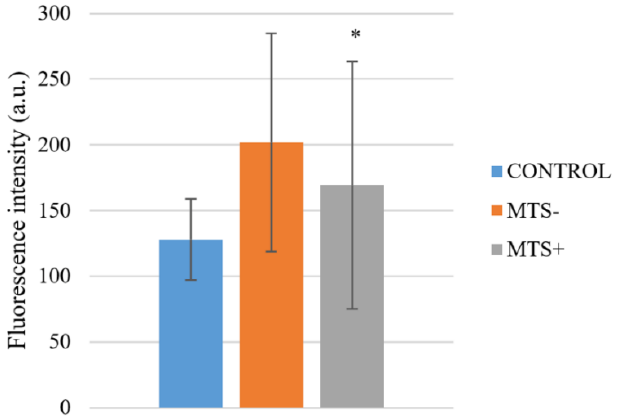
Figure 4. Fluorescence intensity in patients with malignant melanoma with (MTS+) or without metastases (MTS-) compared to the control. Statistically significant difference is between MTS+ and MTS- group. Values are expressed as mean ± SD. * indicates p < 0.05.